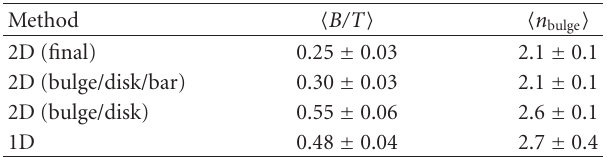
Table 1: Mean B/T ratio and S´ersic n parameter of the bulge as estimated using the 1D and 2D decompositions, applied for the K s - band images. This table was originally published in Laurikainen et al. [62].